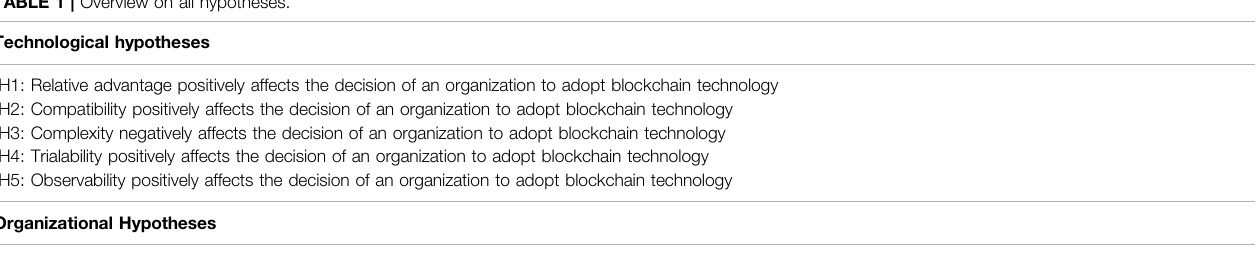
TABLE 1 | Overview on all